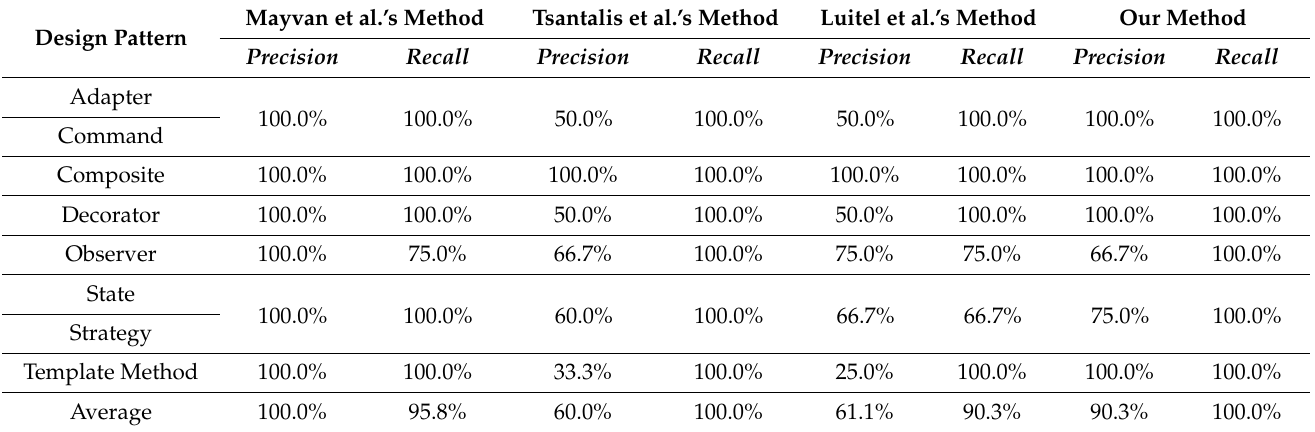
Table 7. The precisions and recalls in JUnit